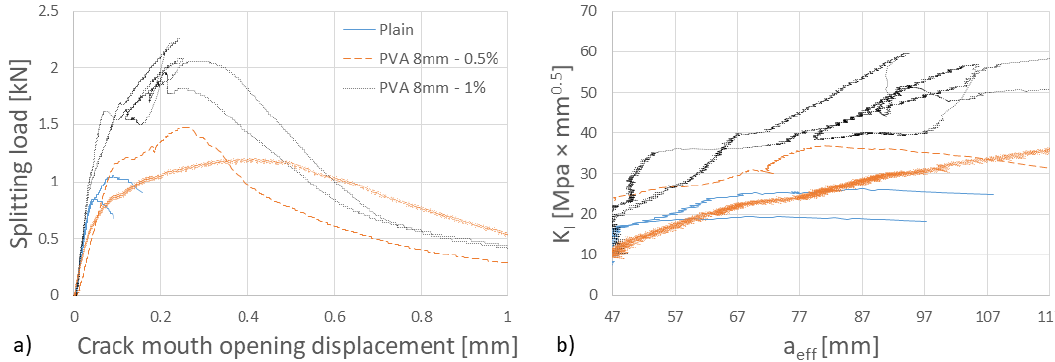
Figure 5. ( a ) Splitting load (SL) versus crack mouth opening displacement (CMOD) curves of 8 mm PVA fiber reinforced concrete (FRC) and ( b ) crack growth resistance curves (in terms of SIFs, KI, compared to effective crack length, aeff) of 8 mm PVA FRC.